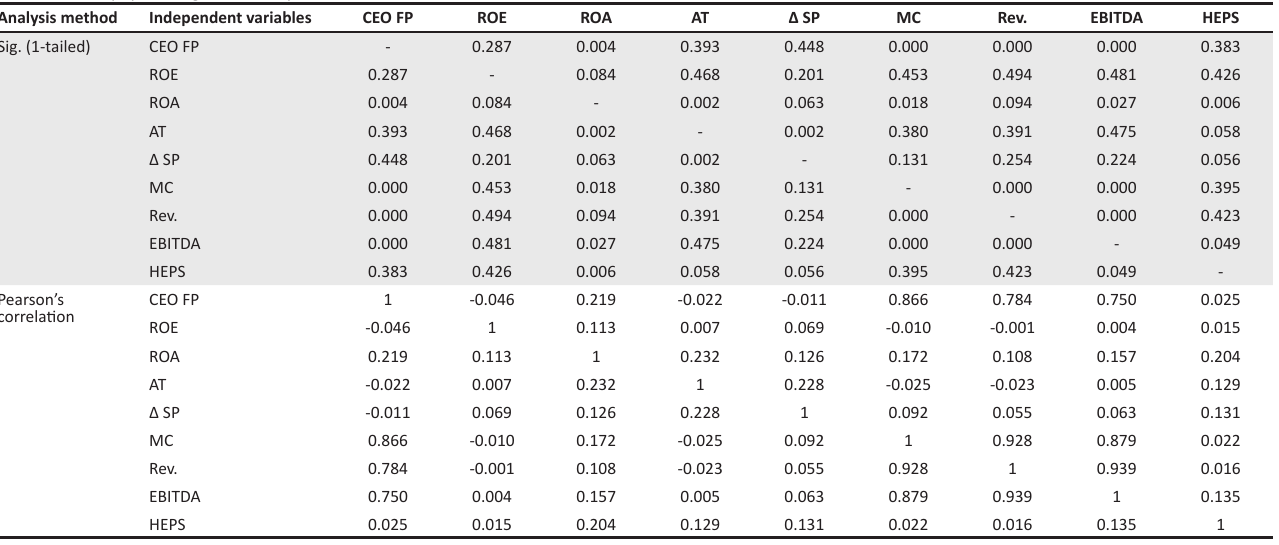
TABLE 2: Fixed pay and organisational performance correlation. Analysis